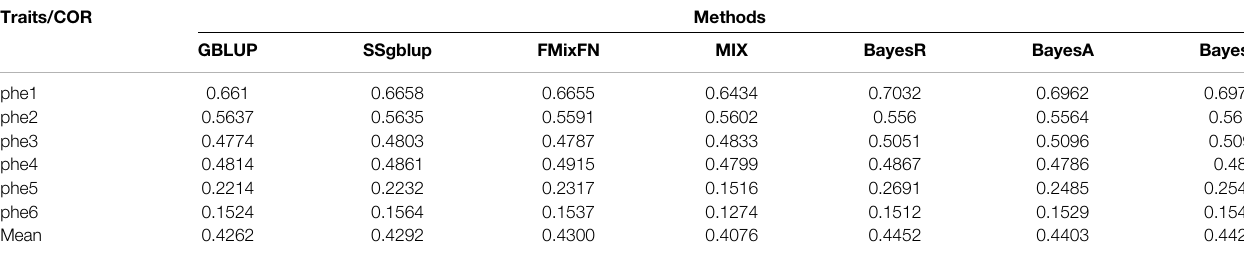
TABLE 1 | Prediction performance in all six traits under the seven predictive methods. Traits/COR